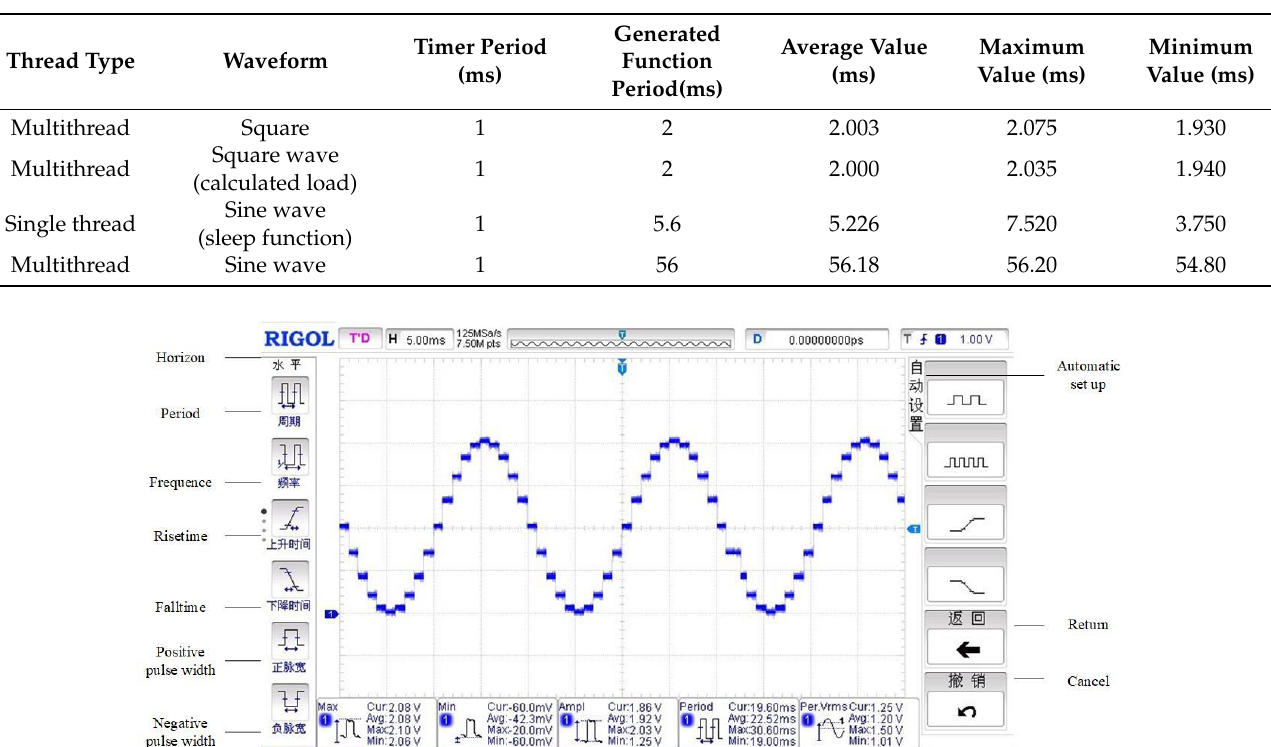
Table 2. Real-time test of the Linux system with the real-time kernel.